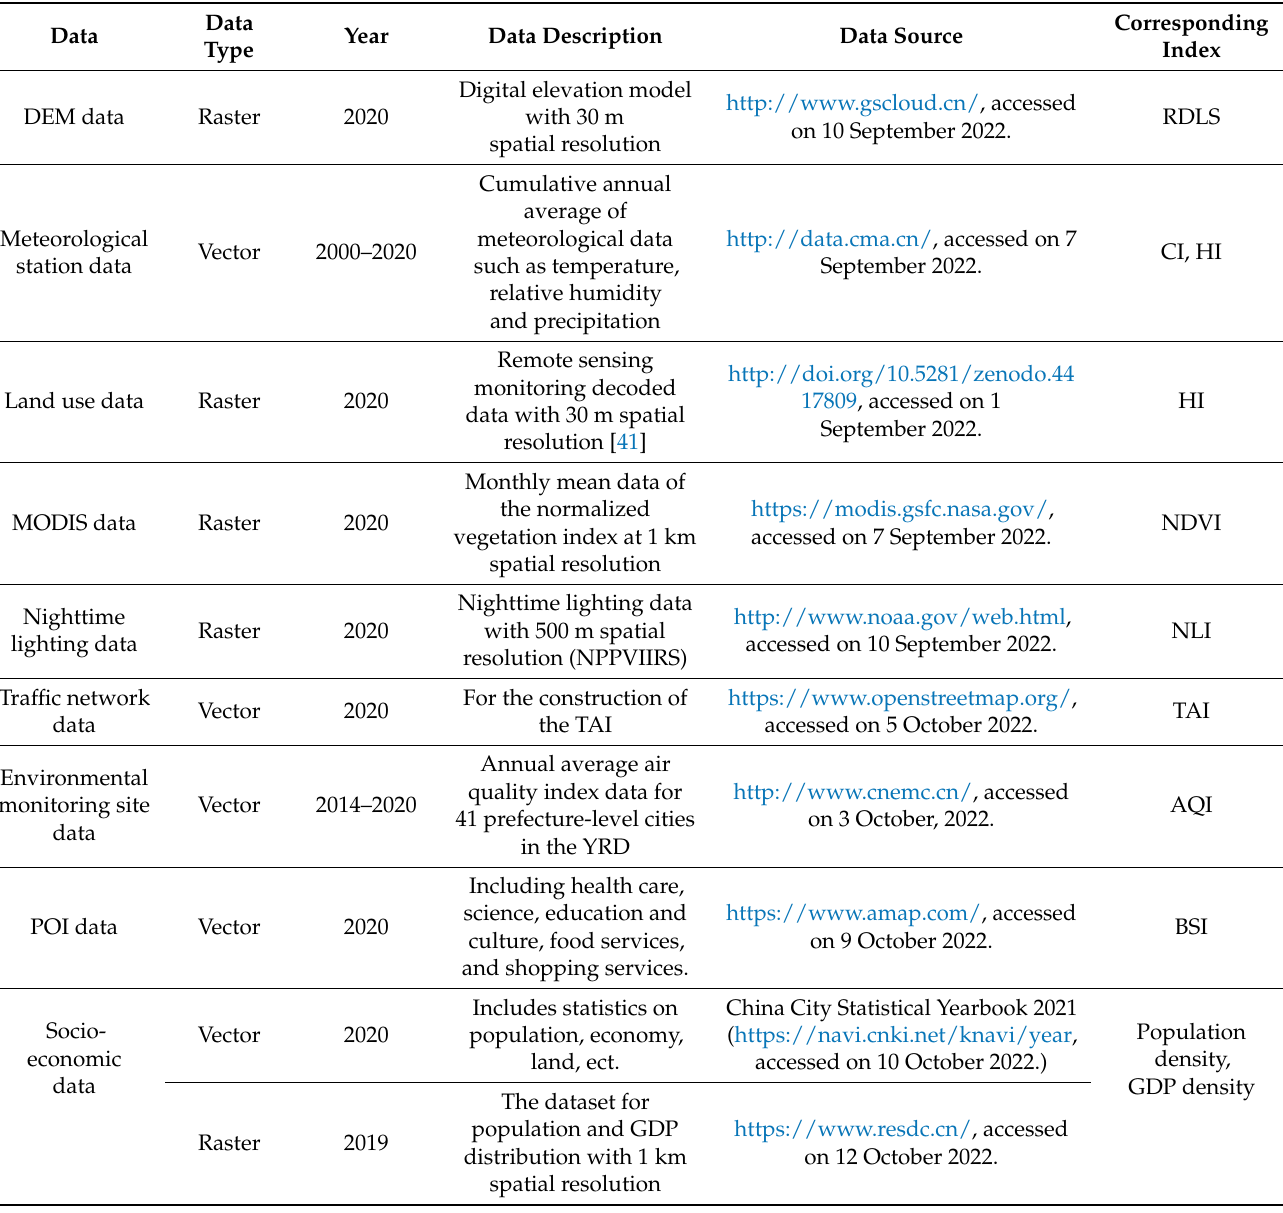
Table 1. Data sources and